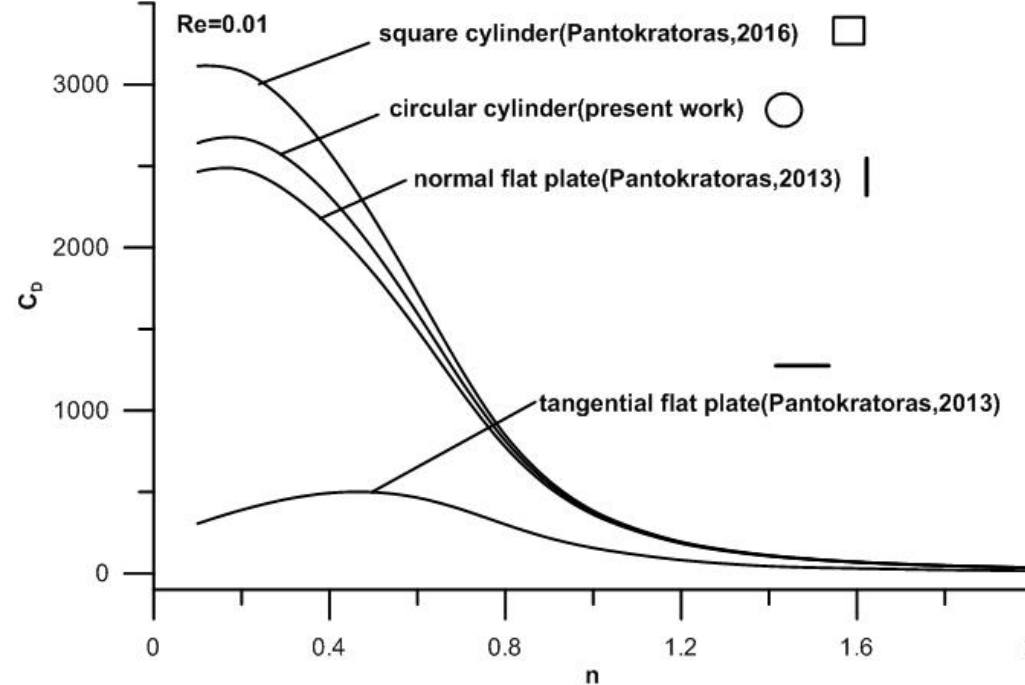
Figure 3. Variation of drag coefficient as a function of the power-law index for Re = 0.01.